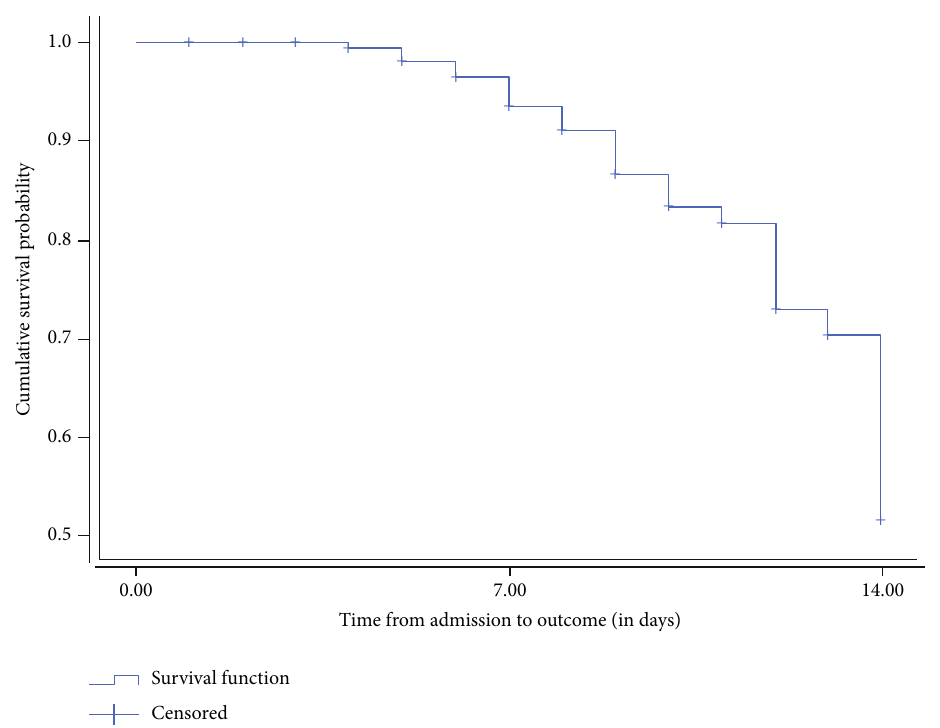
Figure 1: Neonatal survival status among neonates admitted with neonatal sepsis at public hospitals in